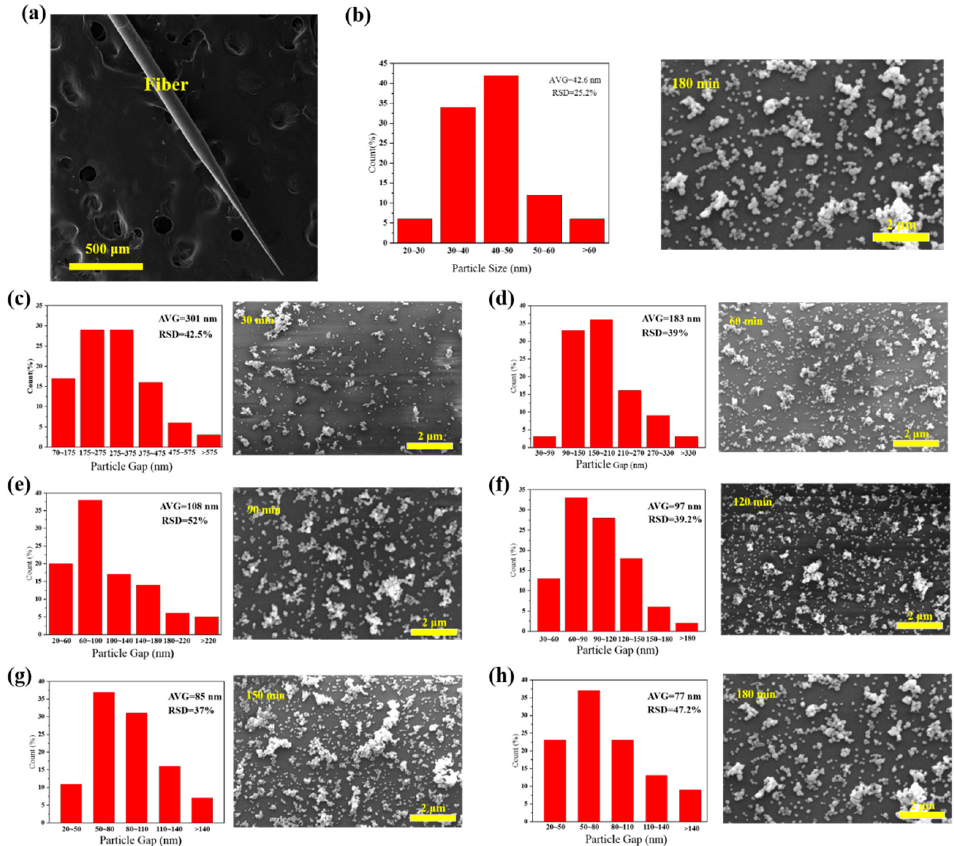
Figure 4. ( a ) SEM (Scanning Electron Microscope) image of a fiber surface-enhanced Raman scattering (SERS) probe (cone angle of 4°); ( b ) size distribution for AgNPs decorated tapered fiber samples and ( c )–( h ) SEM images of different AgNPs deposition time at surface of the tapered fiber tip and corresponding spacing distribution and for 30 min, 60 min, 90 min, 120 min, 150 min and 180 min deposition time, respectively.